Question: Summarize what this figure shows in one sentence.
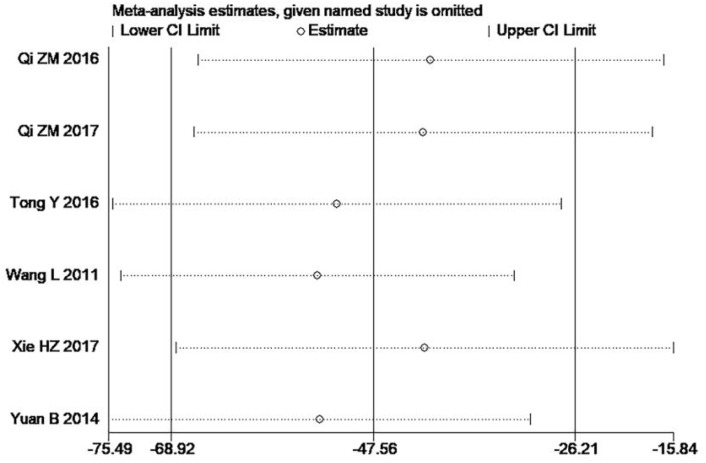
Answer: Results of the UA sensitivity analysis in the CHM vs. WM group.